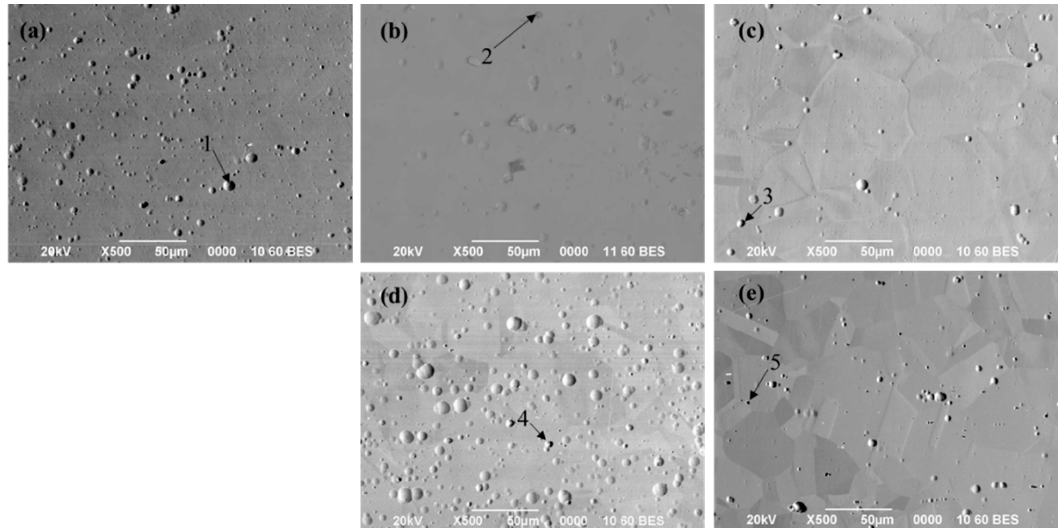
Figure 4. Observation of precipitates (indicated by arrows) on 253 MA ASS from ( a ) cold rolling- arrow no. 1, ( b ) annealing at 1100 °C-arrow no. 2 and with annealing times of ( c ) 900 s-arrow no. 3; ( d ) 1800 s-arrow no. 4; ( e ) 3600 s-arrow no. 5 using SEM and EDAX analyses.